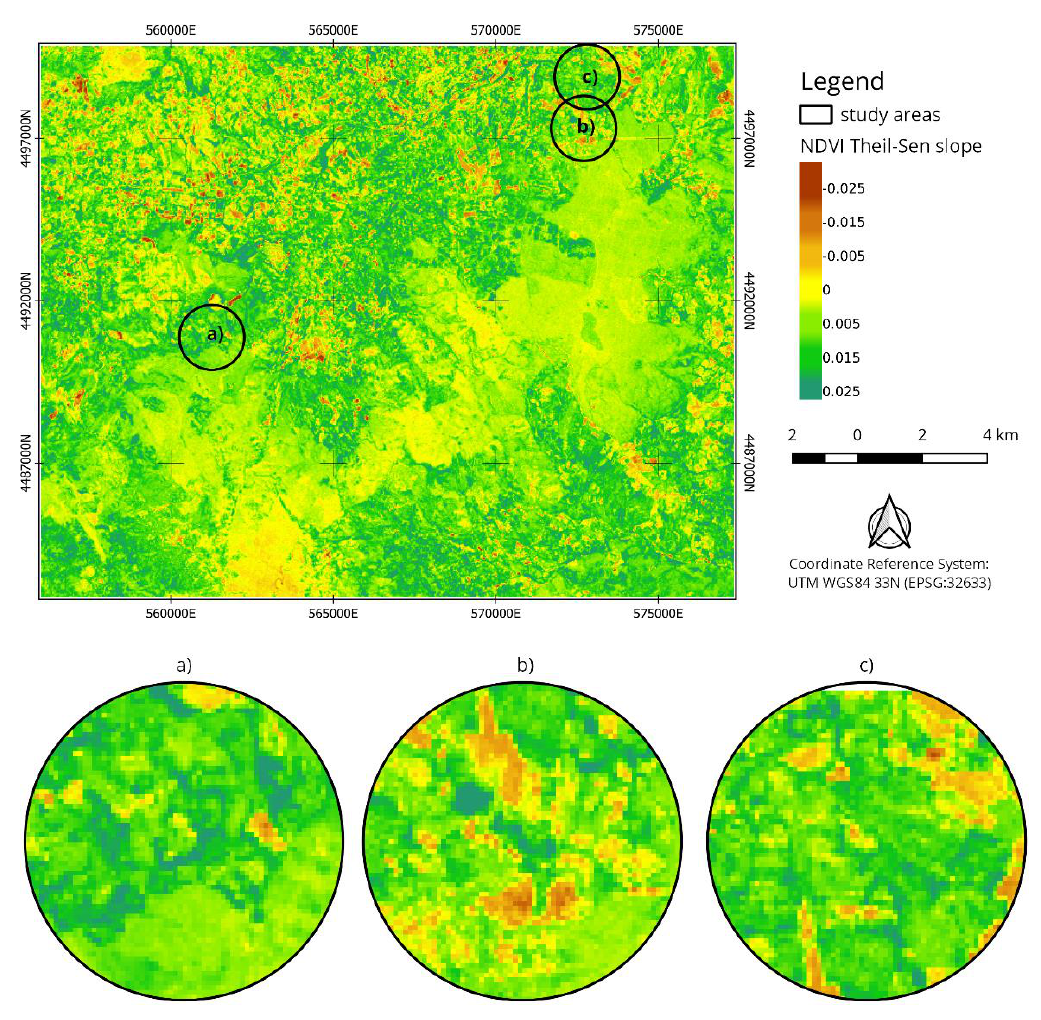
Figure 4. NDVI Theil–Sen slope map of the whole study area and related detail maps of the three sites of interest: ( a ) Aia dei Monaci, ( b ) Montegrosso-Pallareta, ( c ) Vallone Calabrese.